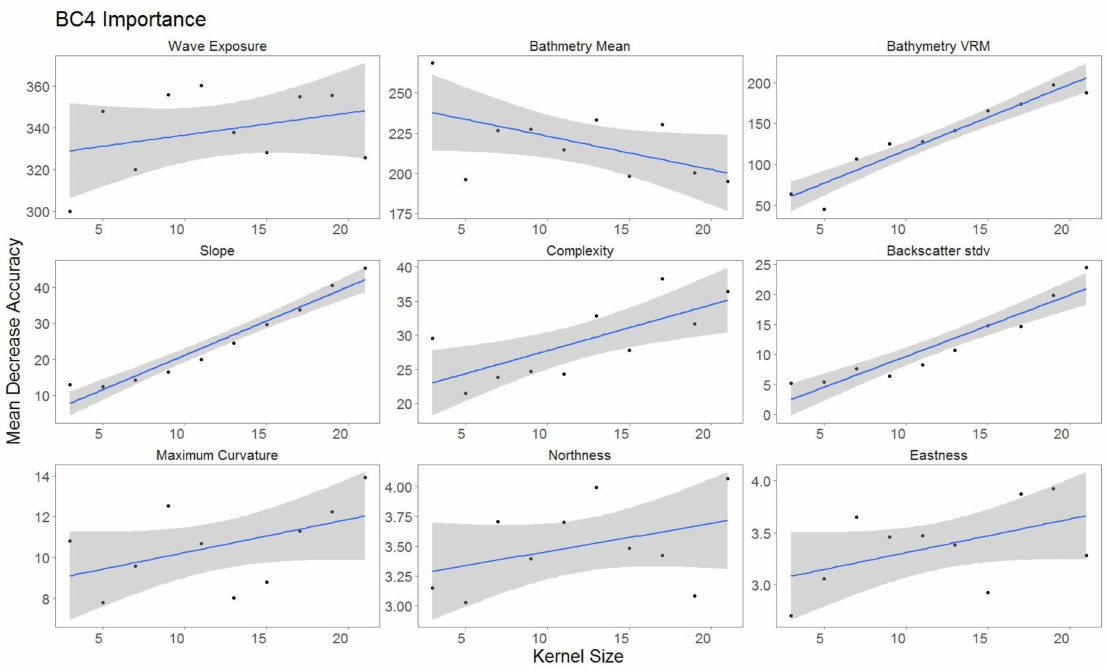
Figure 8. Variable importance for BC4, for variables retained. Sorted by derivatives in order of importance. Generalized linear model (GLM) trend represented in blue. Gray area represents 95% confidence interval for